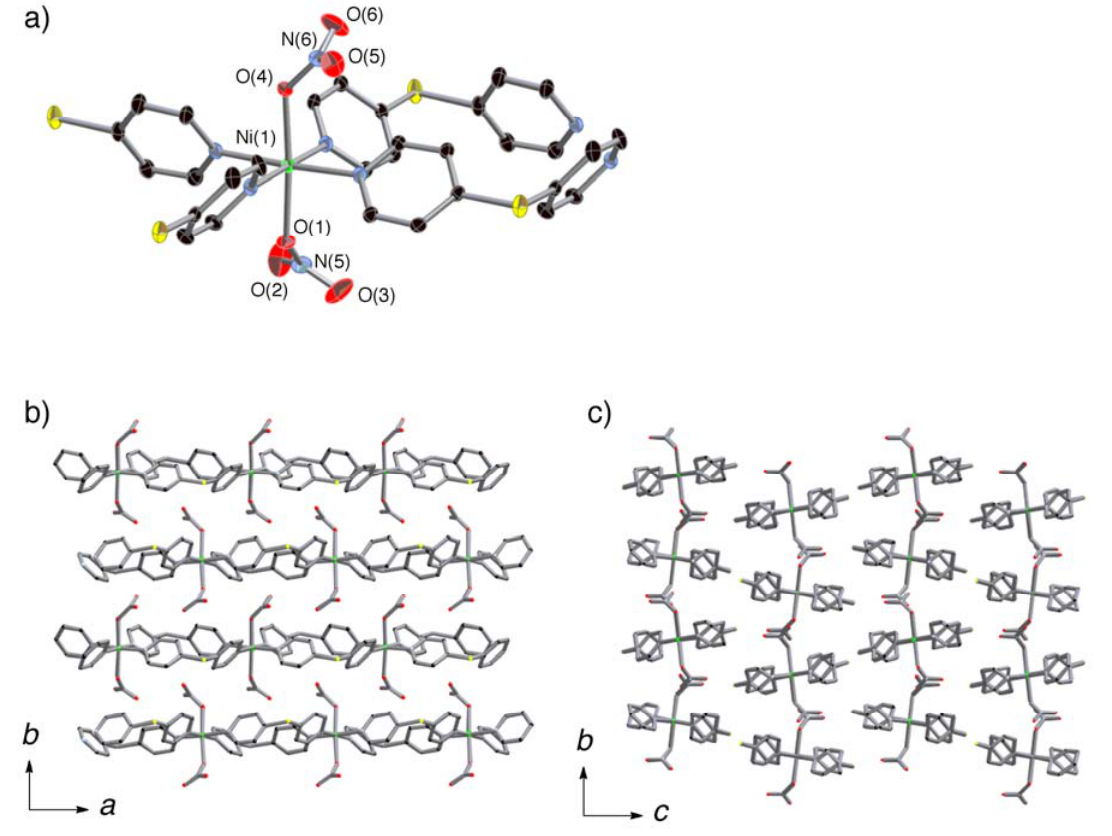
Figure 3. Coordination circumstance of Ni center of 2a ( a ). Views of stacking aspect of ( Ni - dps ) chains of 2a in the ab plane ( b ), and assembled pattern of the chains along the c 2 axis ( c ). Hydrogen atoms are omitted for